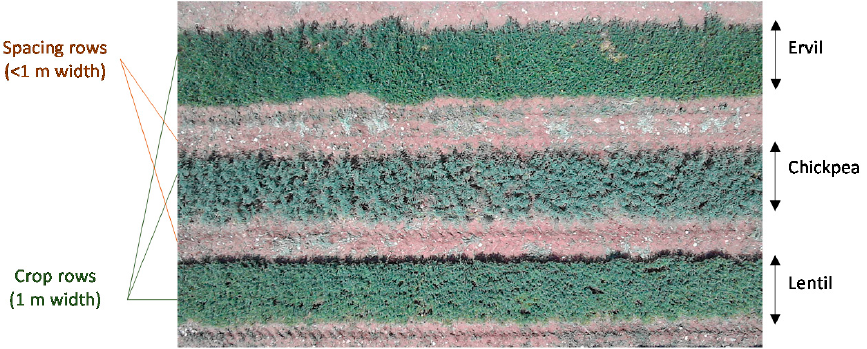
Figure 1. Chickpea, lentil, and ervil rows. Image captured with the Parrot Bebop 2 UAV thermal camera. thermal